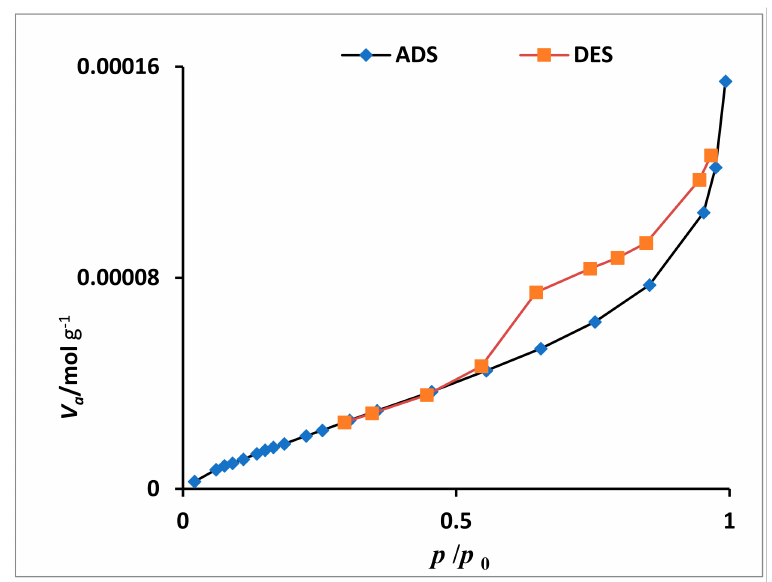
Figure 9. N 2 adsorption–desorption isotherm of Pd@Per-P.